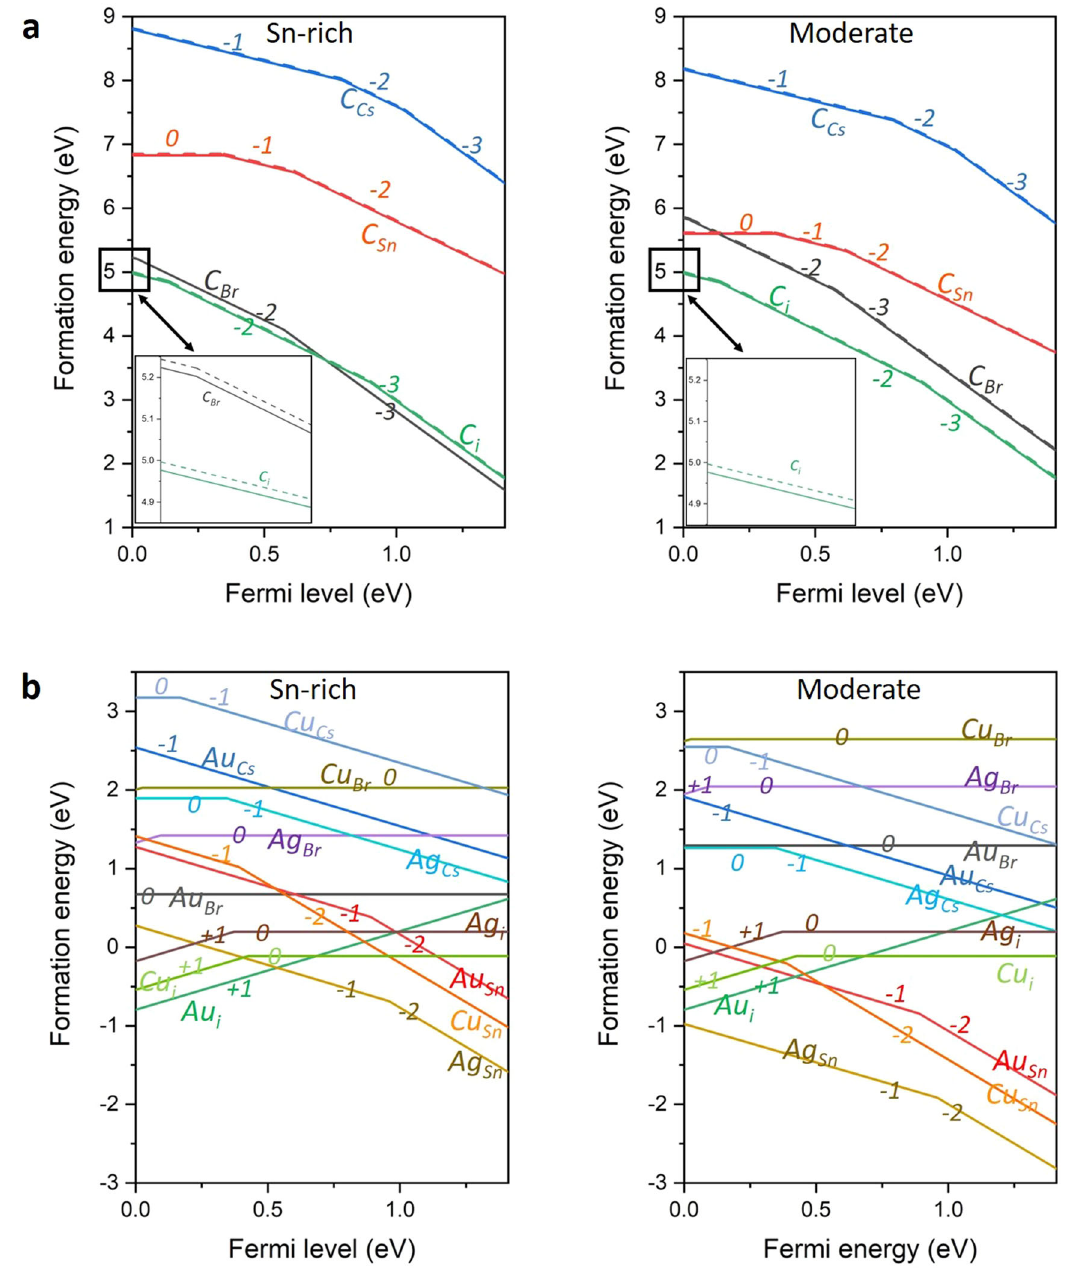
Fig. 2 Impurity formation energies. The calculated formation energies of a carbon (two different carbon sources are considered: graphite (dashed line) or graphene (solid line)), and b metal ( Au , Ag , and Cu ) impurities as a function of the Fermi level, E f , under the Sn -rich and Moderate high diffusion barrier of 1.28 eV. The low formation energies (Fig. 2b) and the high diffusion barriers indicate the metal atoms from the electrodes will be trapped at Sn vacancies near the contact and will be ionized. These impurities ( Au 2 (cid:2) will slowly diffuse into the bulk of CsSnBr 3 over time. Compared to the substitutional impurities in Sn sites, our results show that the interstitial metal impurities ( Au þ lower diffusion barriers in CsSnBr 3 . Especially for Ag þ barrier is only 0.28 eV, indicating the most favorable kinetic